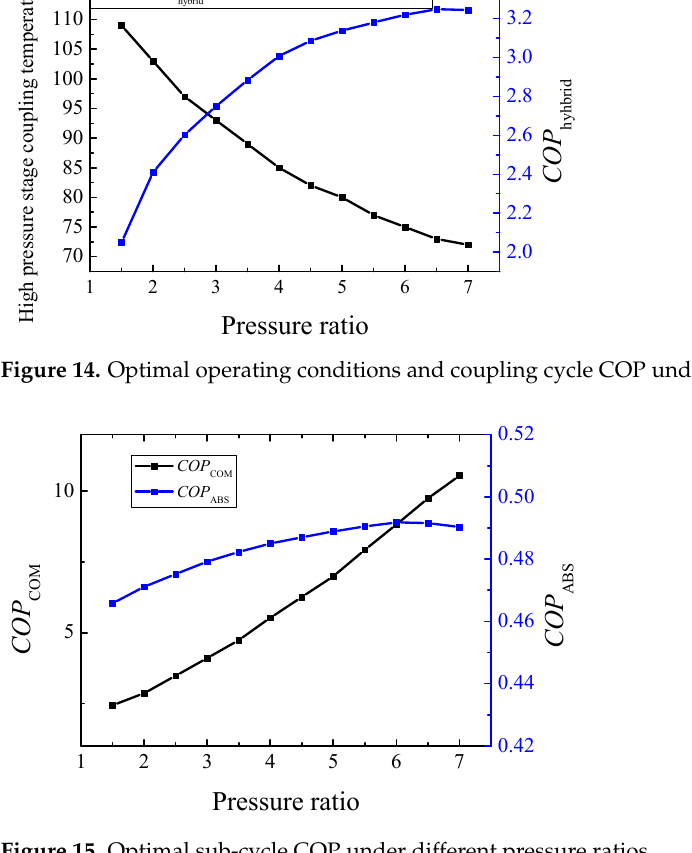
Figure 15. Optimal sub-cycle COP under different pressure ratios.